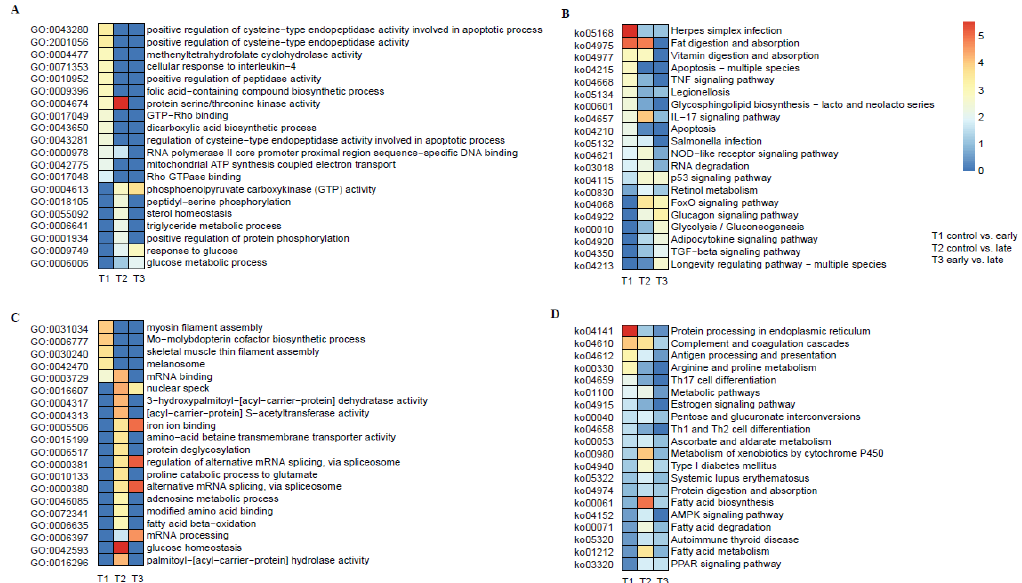
Figure 3. Functional analyses of the top 20 GO and KEGG enrichments based on DEGs from three comparative groups. ( A ) Enriched GO terms for the up-regulated DEGs after the Ichthyophthirius multifiliis (Ich) infections. ( B ) Enriched KEGG pathways for the up-regulated DEGs after the Ich infections. ( C ) Enriched GO terms for the down-regulated DEGs after the Ich infections. ( D ) Enriched KEGG pathways for the down-regulated DEGs after the Ich infections.